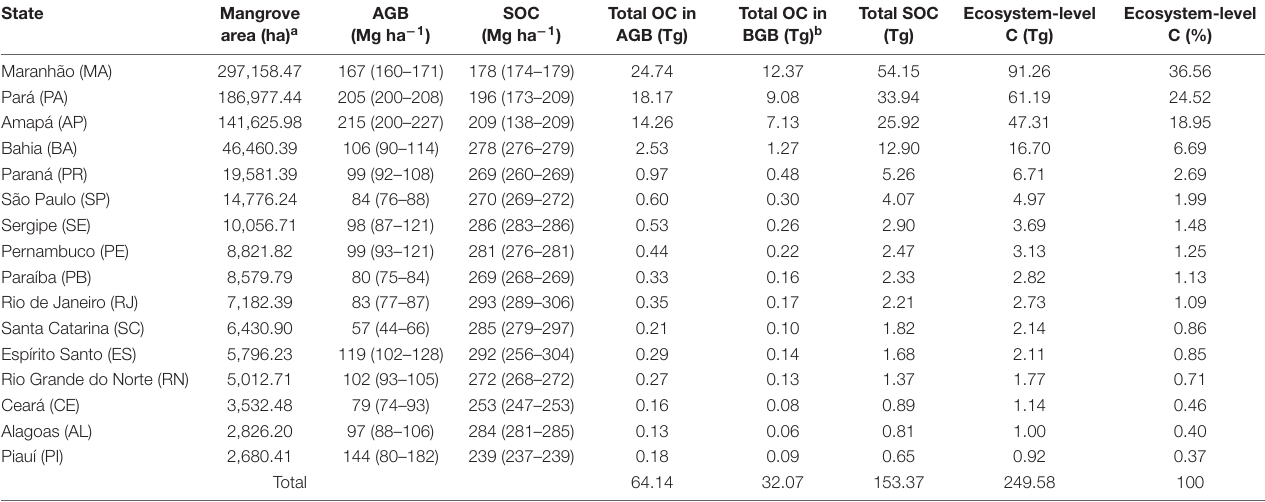
TABLE 2 | Median (95% Confidence Intervals) and total values for above- and belowground biomass (AGB and BGB) and, soil organic carbon (SOC) stock estimates for Brazilian